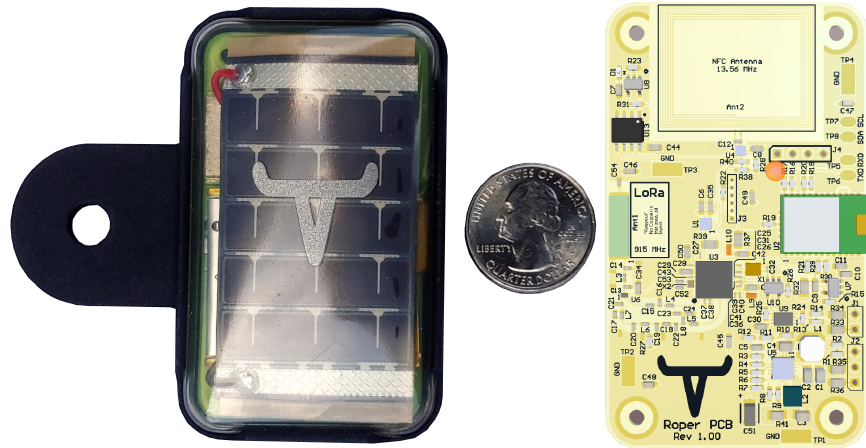
Figure 1. Roper device in housing and the sensor board printed circuit board